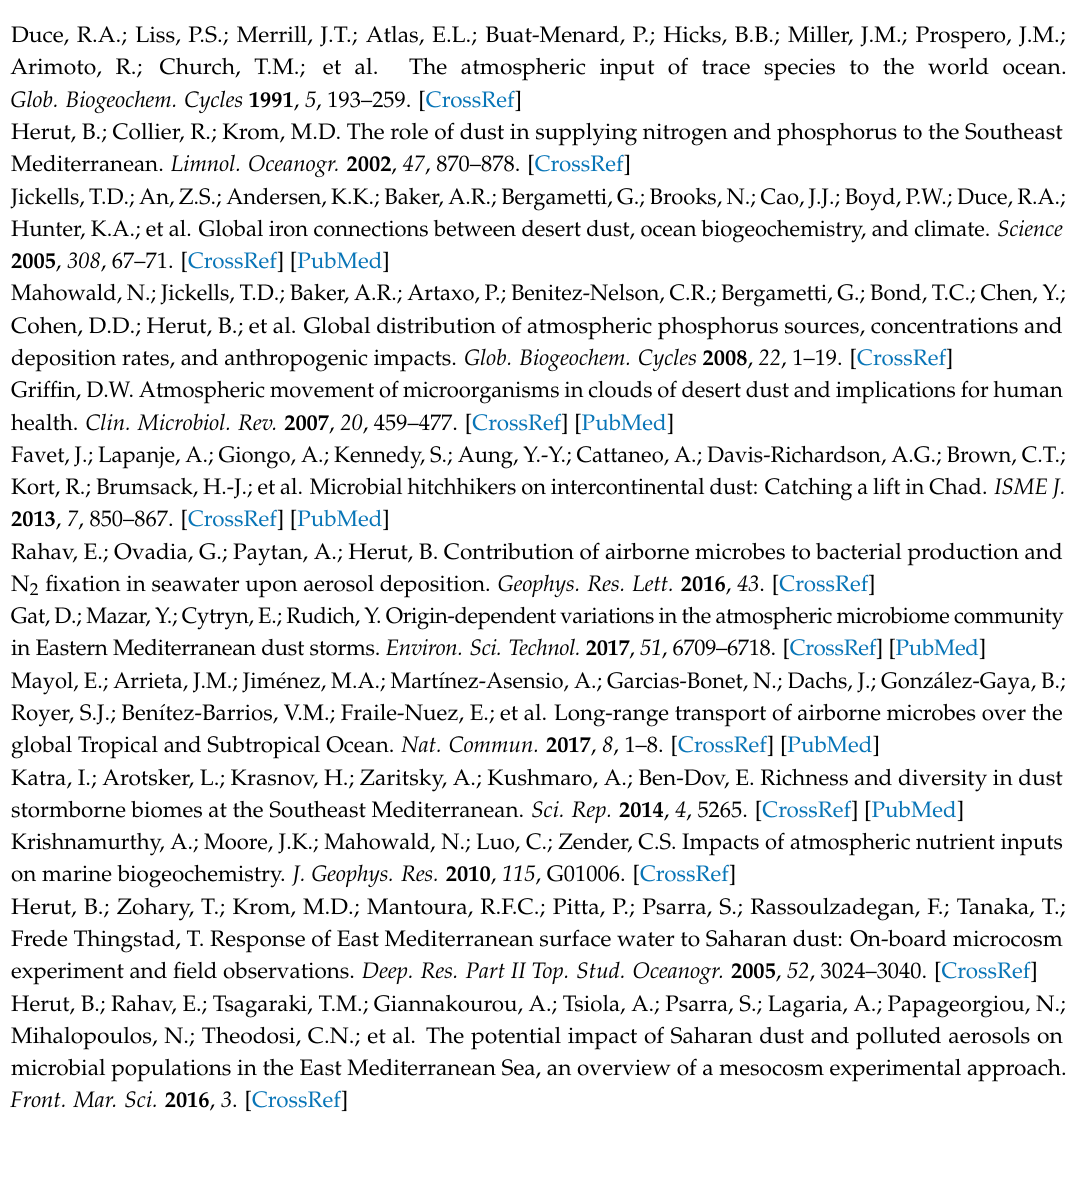
Table S1: Summary of temporal variability in BA, Chl. a , BP, PP, and N 2 fixation in coastal water of Tel-Shikmona, Haifa, Israel, April 2013 to September 2017 during typical (no dust) days. Table S2: Summary of temporal variability in BA, Chl. a , BP, PP, and N 2 fixation in coastal water of Tel-Shikmona, Haifa, Israel, April 2013